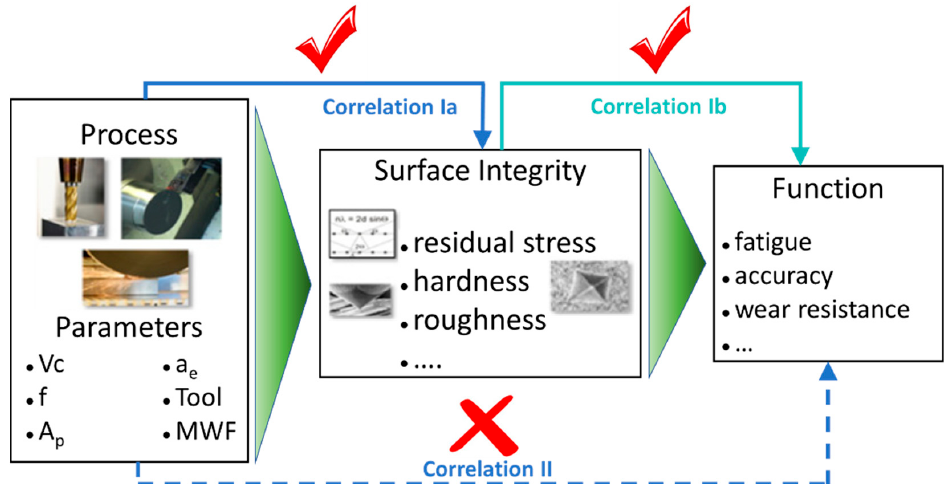
Figure 3. Possible correlations between the process, surface integrity and the expected functionalities